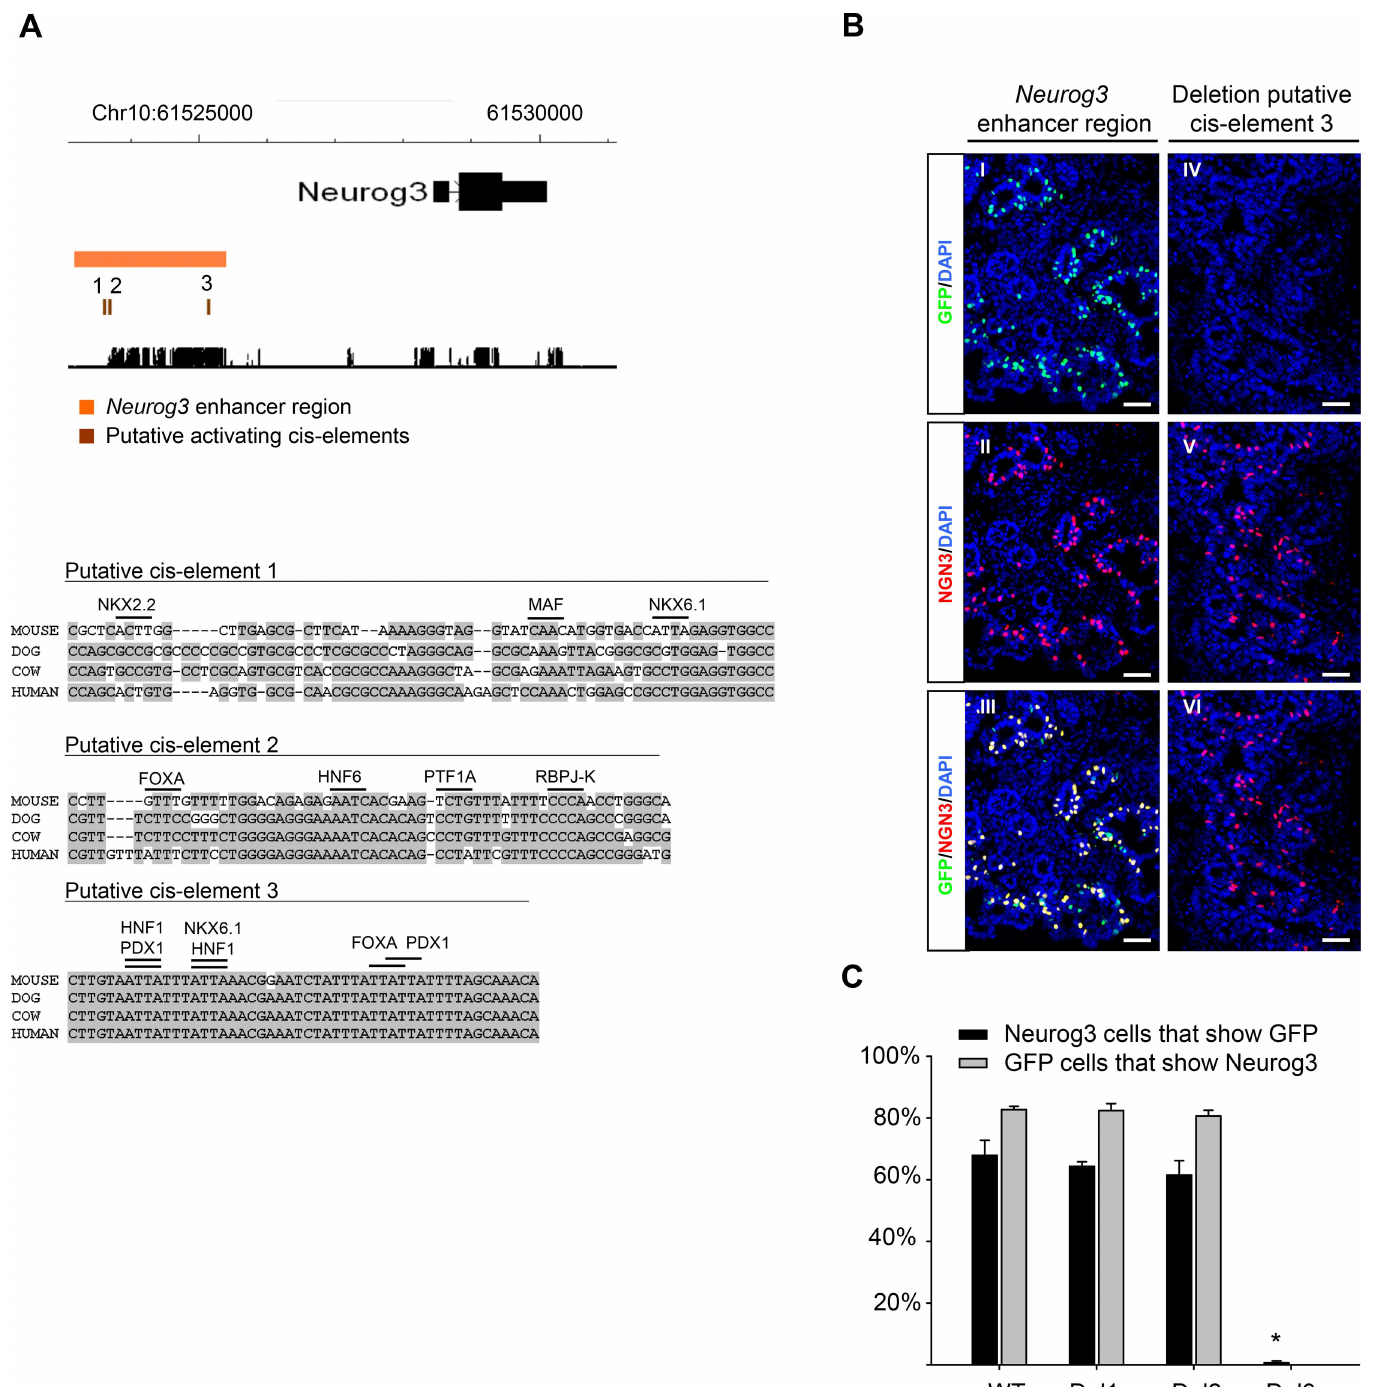
Fig 2. An essential activating cis-element within the Neurog3 enhancer region. A. Three elementsin the Neurog3 enhancer displayedclustered binding motifs for known pancreatic transcription factors. Black lines above sequenceindicate4 bp core of transcription factor motif. B. Deletionof cis-element 3 (Del3; but not 1 or 2) from the Neurog3 enhancerregionleads to a near completeloss of expression. The panels show GFP (green)and Neurog3(red) in an E14.5 transgenic for the wild-type Neurog3 enhancerregion(panelI-III) and a transgenic for the Neurog3 enhancerregionwith activatingcis-element 3 deleted(panelIV-VI). C. Quantificationof percentageof Neurog3cells that are GFP positive (black bars) and the percentage of GFP cells that are Neurog3 positive (grey bars; not present for Del3 becausein 7 out of 8 embryo’s no GFP cells were detected. Quantification was doneon 8 embryos for each genotype in which slides amountingto at least 1000 Neurog3cells were counted([ * ] P = 5.3 x 10 − 9 , Student’s t-test with Bonferroni correction). Scale bars: I-VI = 50 μ m.